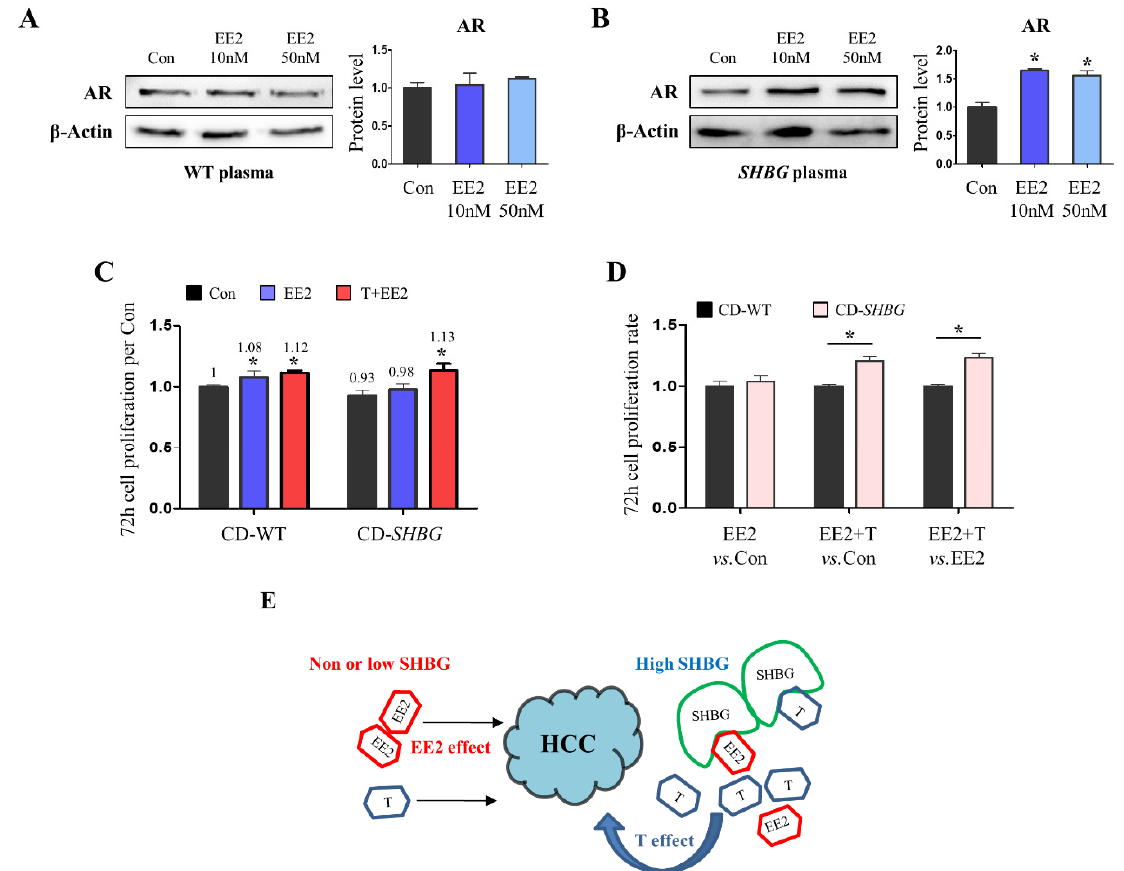
Figure 6. Androgenic effects were accentuated by EE2 in SHBG present SNU423 cells. ( A ) Western blot analysis and quantification of AR in vehicle or EE2-treated SNU423 cells with steroid-present WT plasma. β -Actin was used for an internal control. ( B ) Western blot analysis and quantification of AR in vehicle or EE2-treated SNU423 cells with steroid-present SHBG plasma. β -Actin was used for an internal control. ( C ) Cell proliferation rate of vehicle or EE2-treated SNU423 cells with CD-WT or CD-SHBG plasma after 72 h incubation. EE2 was treated for 48 h following 24 h of vehicle or testosterone